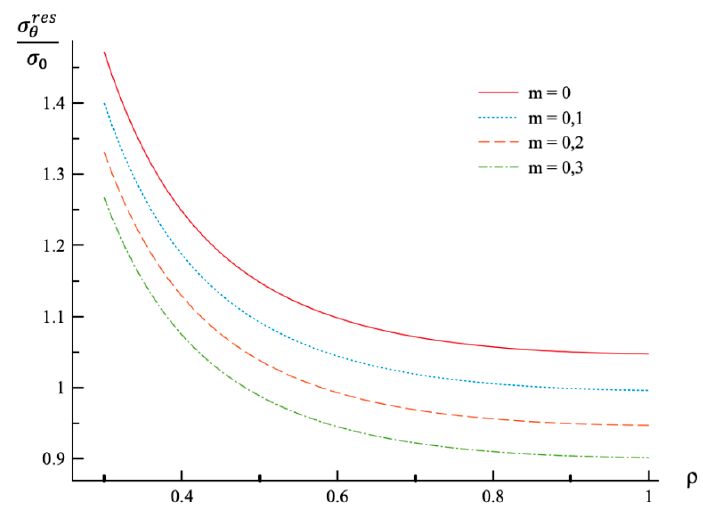
Figure 7. Variation of the residual circumferential stress, σ res